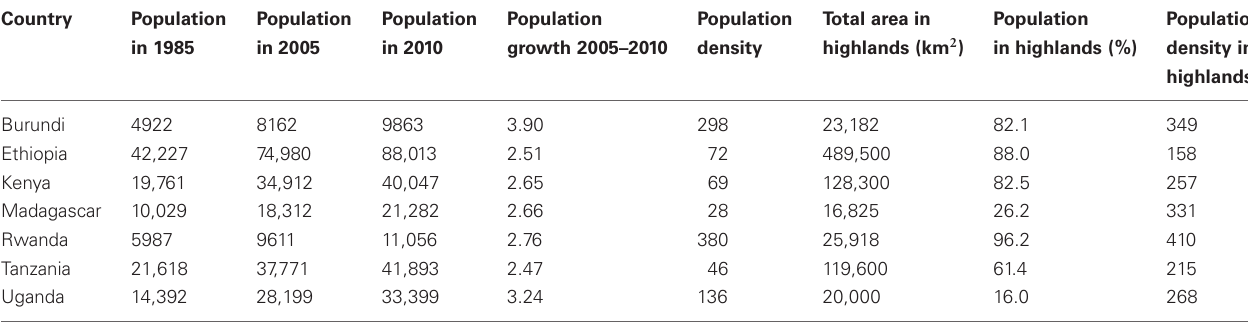
Table 1 | Population density in East African highlands.